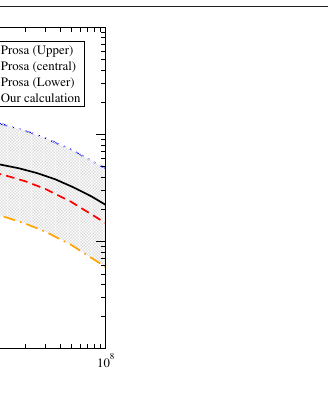
Figure 2. Comparison of our predictions for the prompt neutrino flux and the Prosa